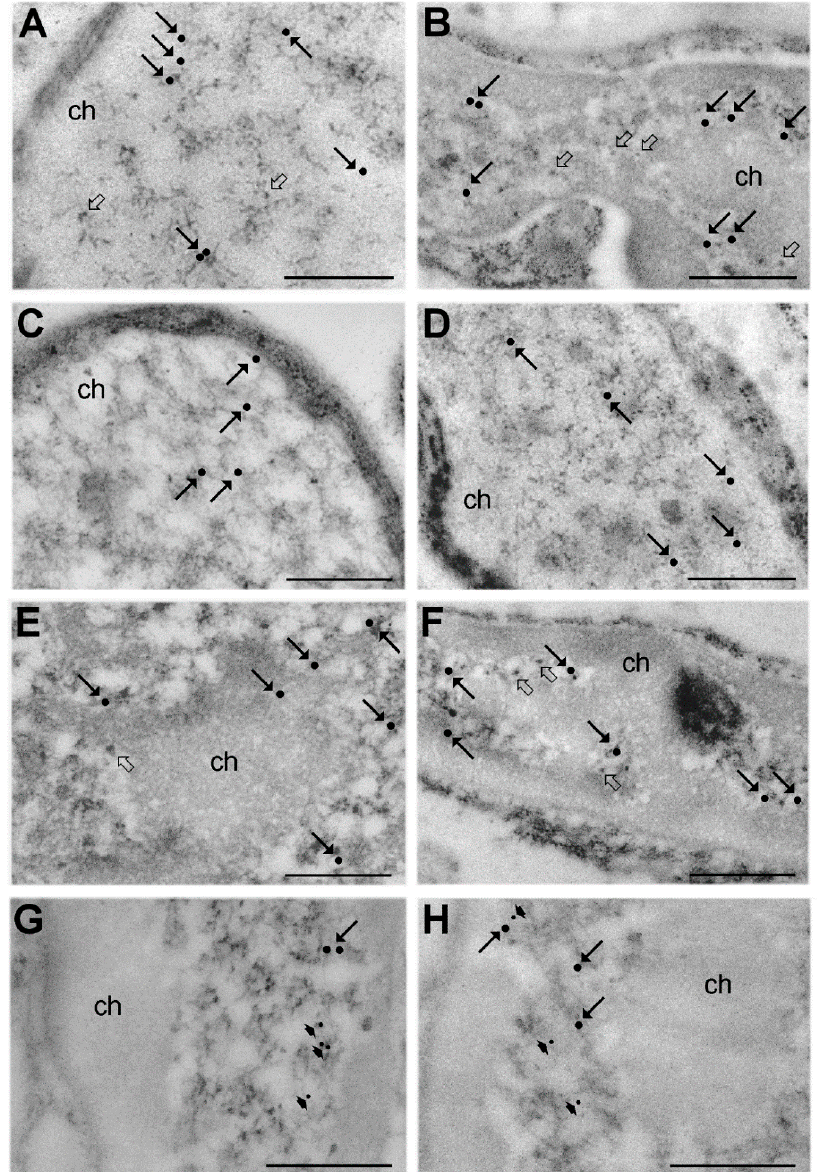
Figure 2. Immunoelectron microscopy. SC nuclei from euthermic ( A , C , E , G ) and hibernating ( B , D , F , H ) dormice; immunolabelling for RNA polymerase II ( A , B ; arrows), DNA / RNA hybrid molecules ( C , D ; arrows), small nuclear RiboNucleoProtein ((Sm)snRNP) core protein ( E , F ; arrows), paired box protein 7 (Pax7) ( G , H ; arrows) and the myogenic di ff erentiation transcription factor D (MyoD) ( G , H ; arrowheads). All antibodies specifically label perichromatin fibrils (PFs) that mostly occur at the periphery of heterochromatin clumps (ch). Perichromatin granules (PGs) are indicated by open arrows ( A , B , E , F ). Gold particles were digitally enhanced to improve their visibility. Bars: 500 nm.